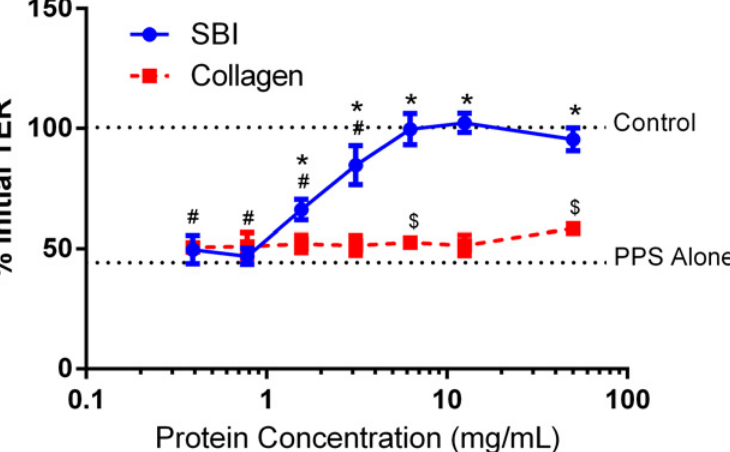
Fig 4. Damaging the Co-Culture C2BBe1 Monolayer. Addition of 0.01% PPS to the apical compartment C2BBe1 transwell culture plates resulted in a 60 – 70% reduction in TER. The addition of SBI inhibited the PPS-induced loss in TER as SBI concentrations were increased from 0.8 mg/mL, with complete inhibition of PPS-induced barrier damage observed at concentrations above 6.25 mg/mL. Inhibition of PPS-induced loss of TER required the functional proteins in SBI, as the control protein collagen had no effect on PPS induced barrier damage. * indicates P < 0.05, when comparing the difference between SBI at varying concentrations and PPS alone. # indicates P < 0.05, when comparing the difference between SBI at varying concentrations and the control TER value. $ indicates P < 0.05, when comparing the difference between collagen at varying concentrations and PPS